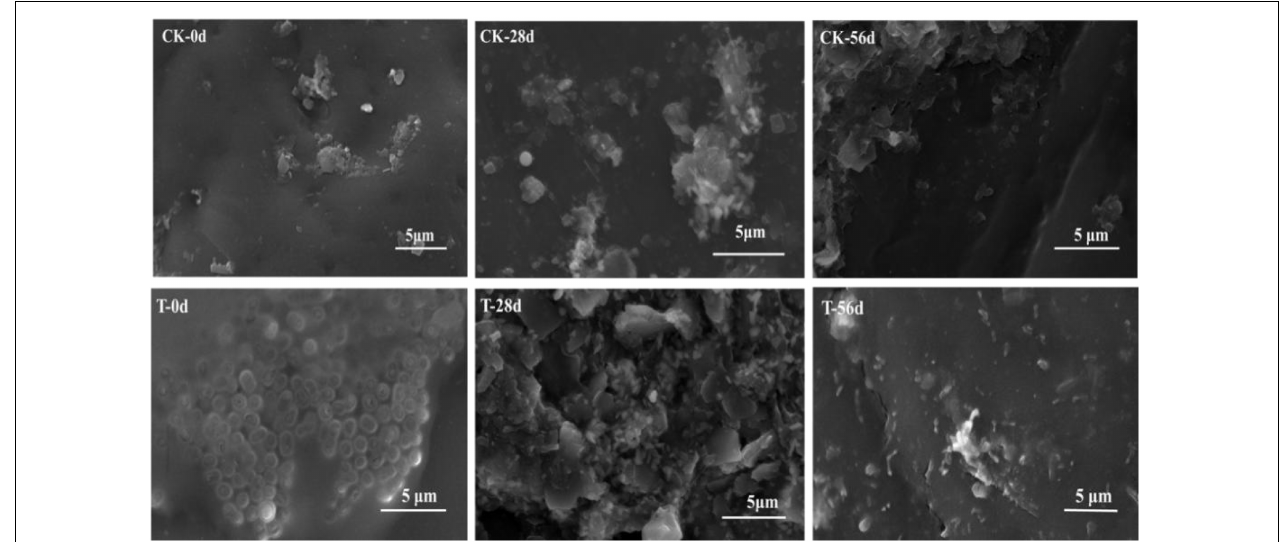
FIGURE 4 | Biofilms on the PHPS observed under SEM (CK, control check; T, treatment).